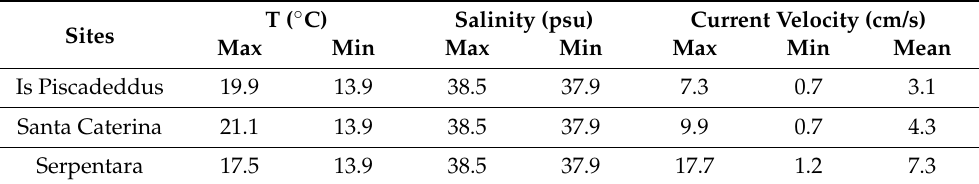
Table 3. Minimum and maximum values (between 2017 and 2019) of monthly three-dimensional oceanographic variables from the high-resolution Mediterranean Sea MFC physical reanalysis product (MEDSEA) [39], retrieved from the E.U. Copernicus Marine Service Information platform, available at https://resources.marine.copernicus.eu/product-detail/MEDSEA_MULTIYEAR_PHY_006_00